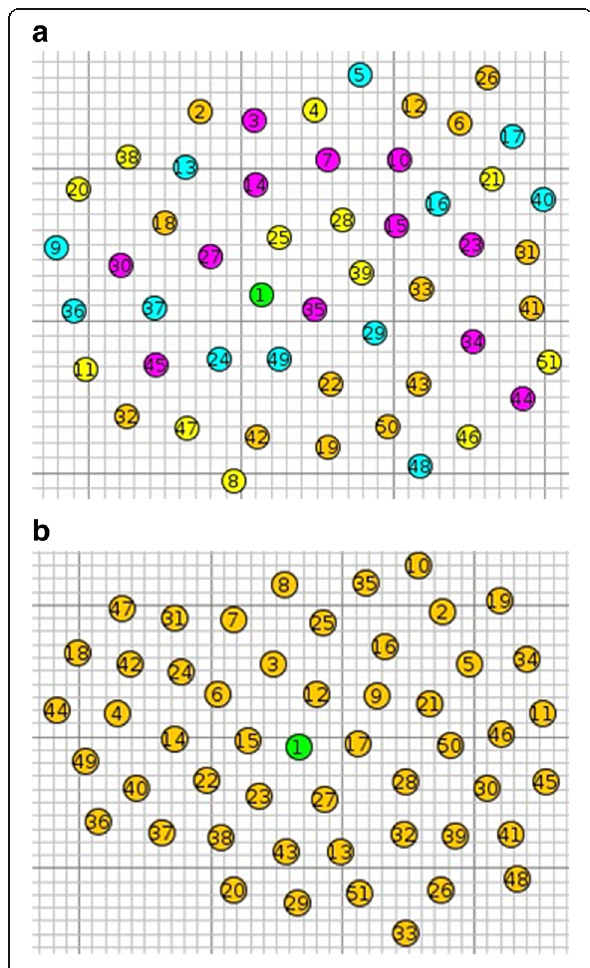
Fig. 20 Simulation analysis for the scenario a random topology with fixed heterogeneous traffic load and b random topology with varying heterogeneous traffic load